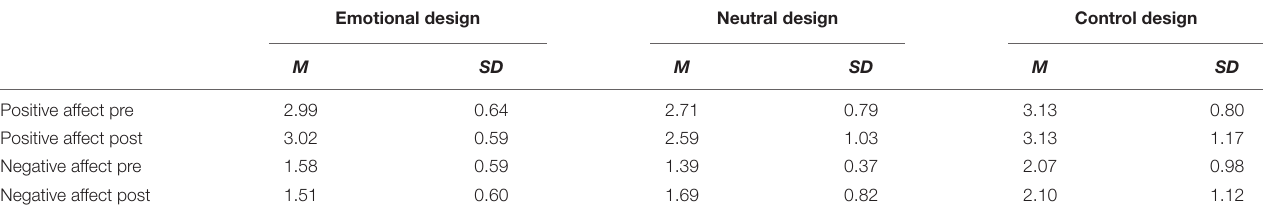
TABLE 2 | Means and standard deviations of the positive and the negative affect. Emotional